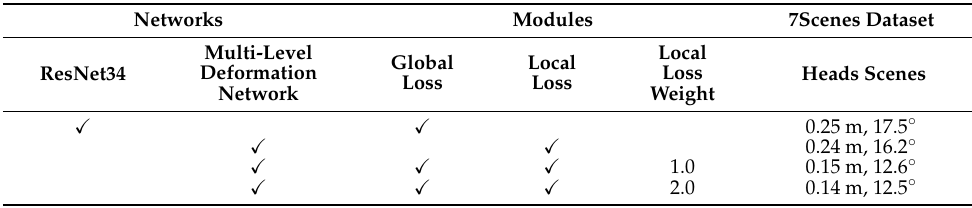
Table 6. Positioning errors in the Heads scenario of the 7Scenes dataset using different networks and loss functions. (Here (cid:88) means that this network module and loss function(s) are used in the